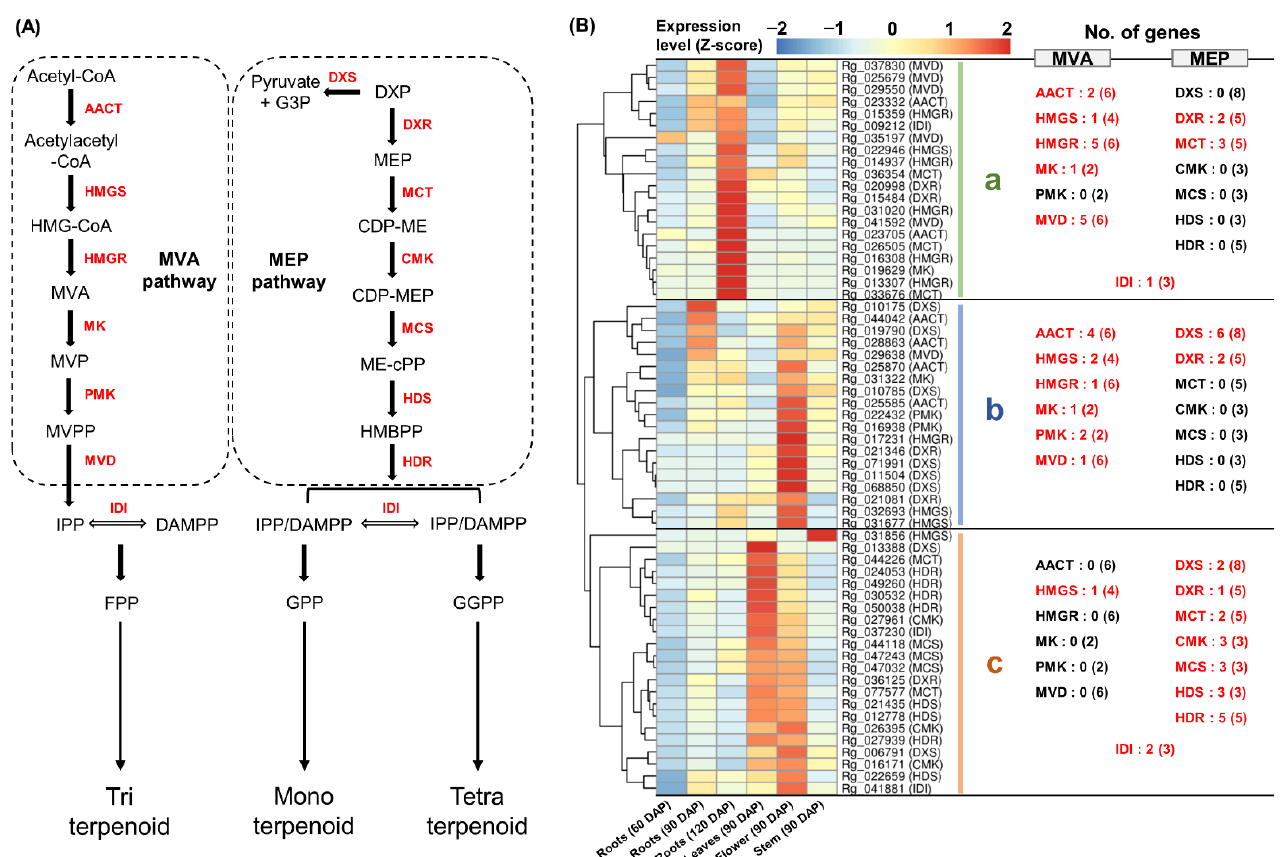
Figure 3. Expression analysis of genes involved in MVA and MEP biosynthesis. ( A ) MVA and MEP biosynthetic pathway in plants. ( B ) Heatmap analysis of MVA and MEP biosynthetic genes. ( a ) Genes cluster showing a strong expression in the 120 DAP roots. ( b ) Genes cluster showing a constitutive expression in most tissues. ( c ) Genes cluster showing a strong expression in the leaves and flowers at 90 DAP. Genes highlighted in red indicate genes assigned to each cluster and the number in parentheses is the total number of genes encoding the enzyme expressed in R. glutinosa transcriptome. MVA , mevalonate phosphate; MEP , methylerythritol 4 ‐ phosphate.